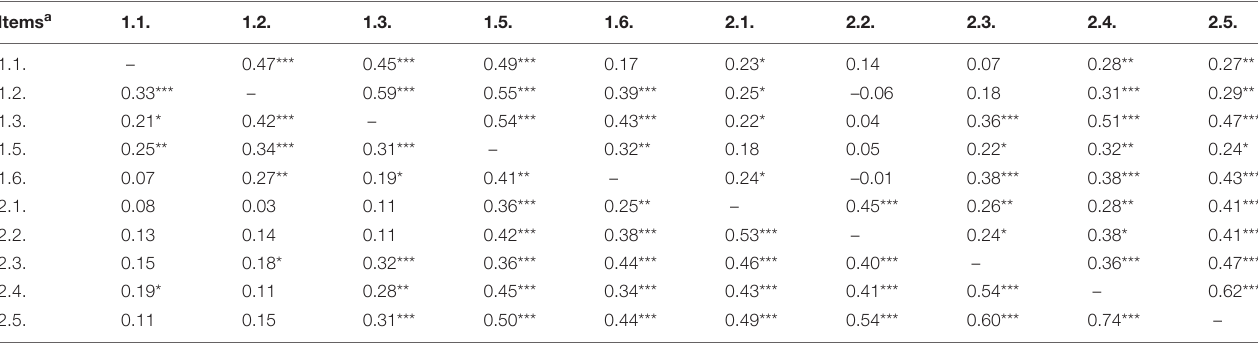
TABLE 4 | Pearson correlations of the 10 items of emotional agency for data sets 1 and 2, representing professionals from real estate services (below the diagonal; n = 138) and healthcare (above the diagonal; n = 102), respectively. Items a 1.1.